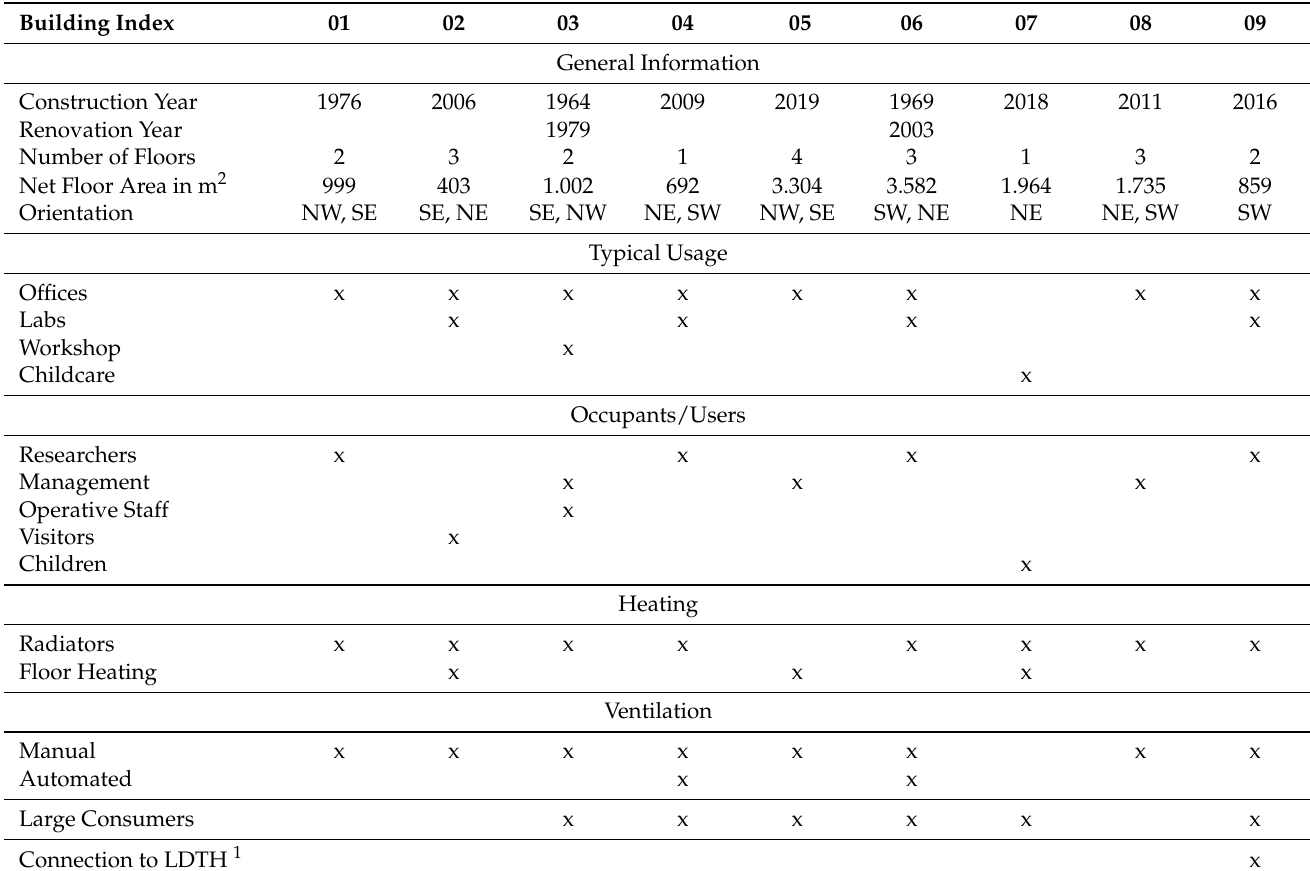
Table 2. Overview of selected buildings and their characteristics (Group